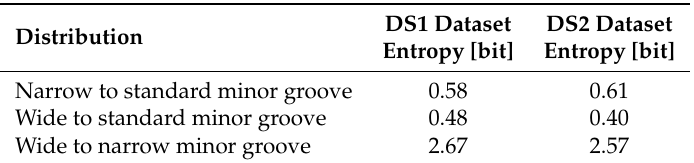
Table 1. Differences between the amino acid frequency distributions found in narrow, standard, and wide minor grooves measured using relative